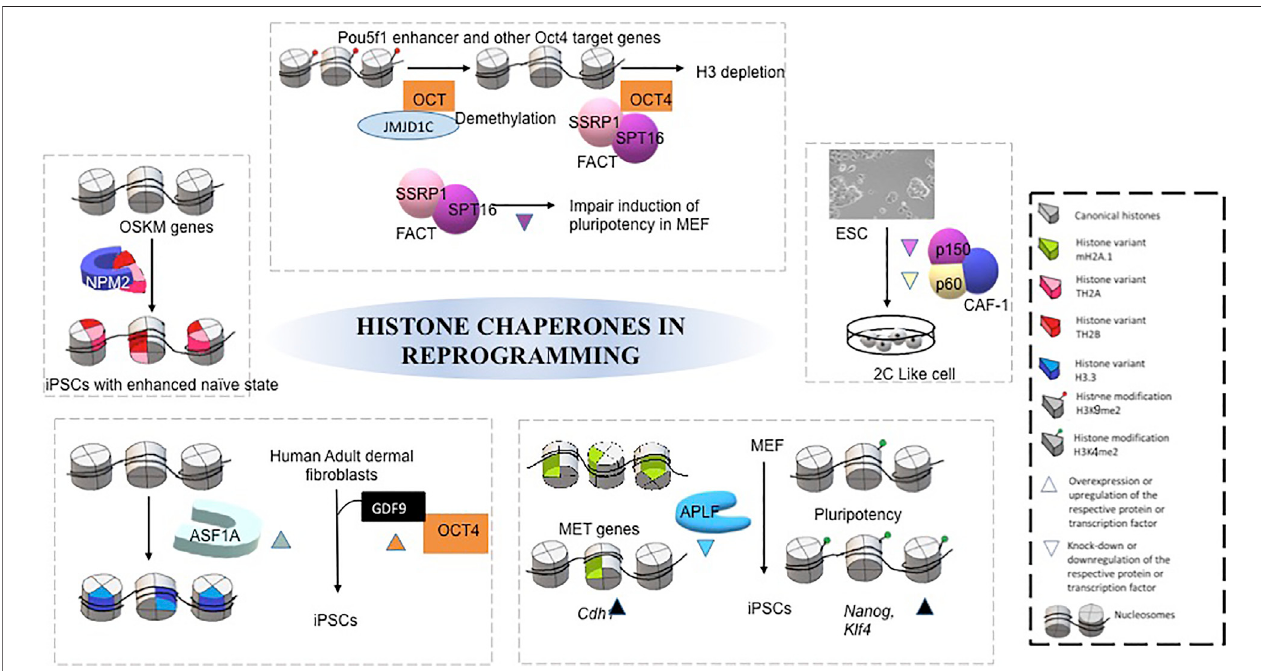
FIGURE 3 | Mechanism of different histone chaperones in facilitating acquisition of pluripotency by reprogramming. Each separate box represents mechanism by which different histone chaperone facilitate reprogramming, mediated by different transcription factors, histone modi fi cations, growth factors and histone variants (Gonzalez-Muñoz et al., 2014; Ishiuchi et al., 2015; Shakya et al., 2015; Fernández-Rivero et al., 2016; Syed et al., 2016; Shen Z et al., 2018).